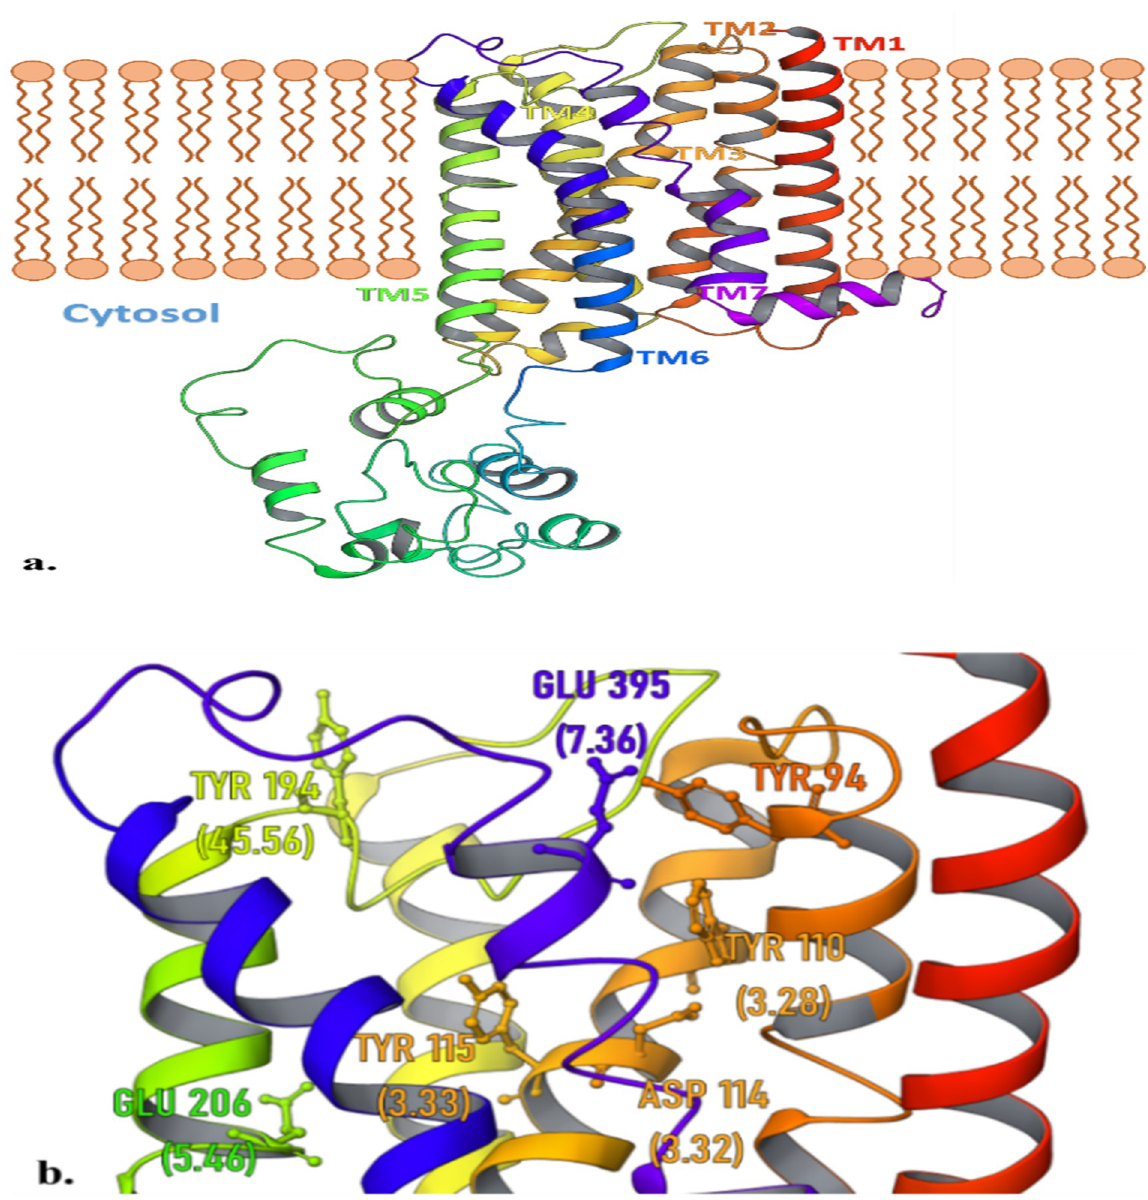
Fig 3. tRosetta modelled structure of human H3R receptor. (A) The H3R is featured using successive transmembrane (TM) domains; the big cytosolic lobe is associated with the effector activity with G-protein. (B) Catalytically active residues of H3R take part in agonist and antagonist